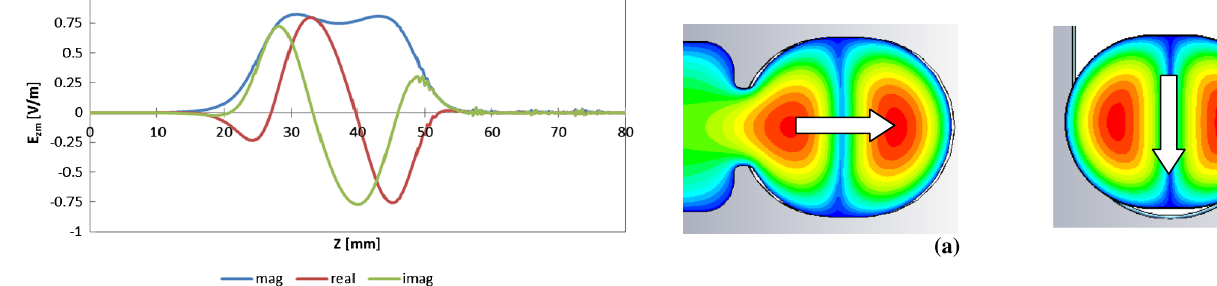
FIG. 17. Longitudinal electric field (a) TE coupled vertically to the dipole mode. Arrow tally and (b) TE 20 shows the direction of power